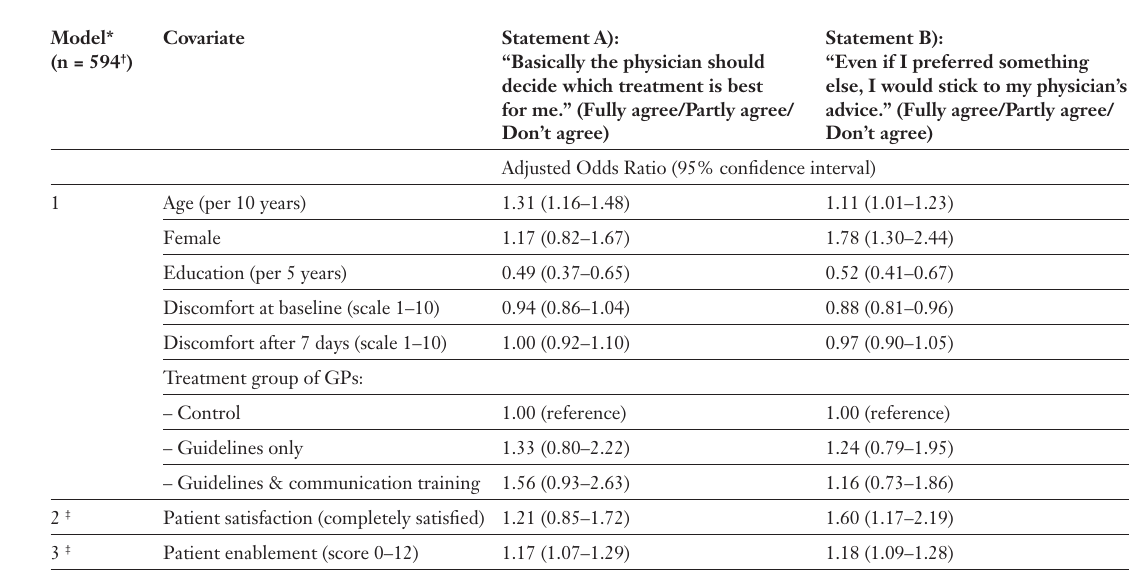
Table 3 Odds ratios for proportional odds models 1 to